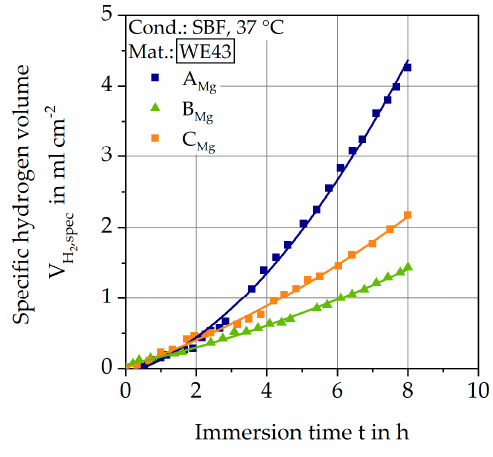
Figure 17. Results of immersion tests in SBF at 37 °C. Table 4. Characteristic values of the potentiodynamic polarization and immersion tests.